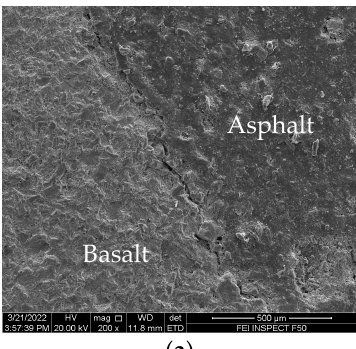
magnification; ( c ) ×1000 magnification.